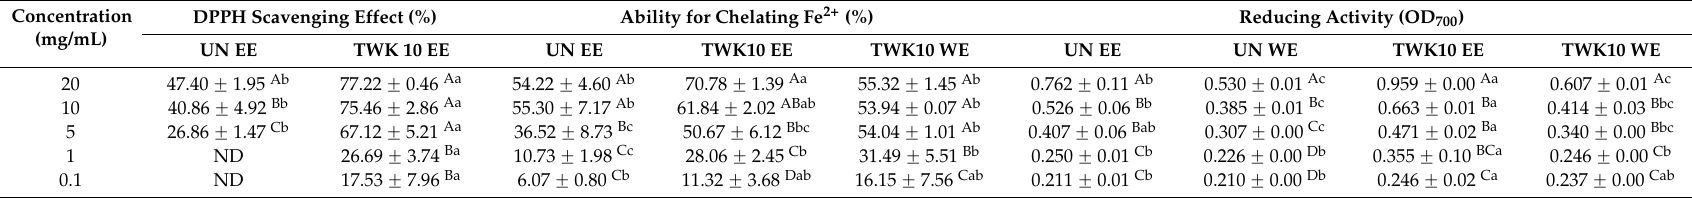
Table 1. The scavenging effect of DPPH radicals, ability for chelating Fe 2+ and reducing activity of extracts of unfermented soymilk and TWK10-fermented soymilk. Concentration